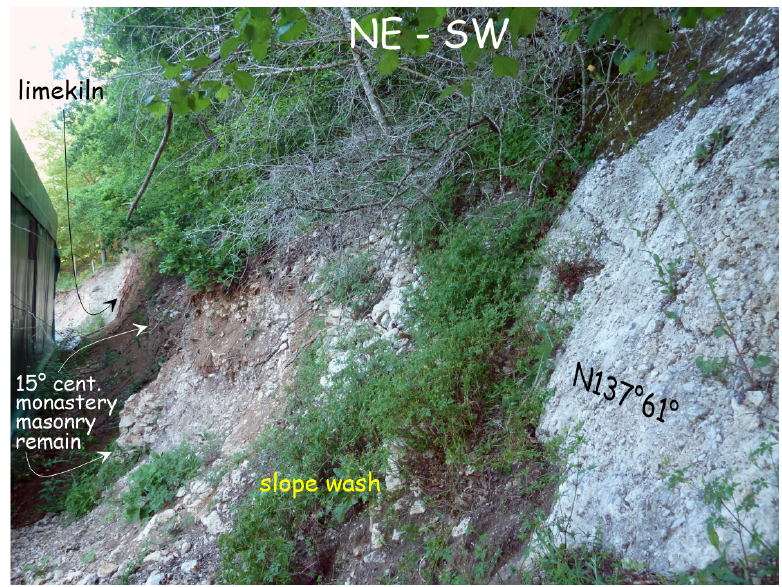
Figure 5. View looking northwest of the fault scarp and of the carbonate slickenside close to the kiln. The fault here juxtaposes marine limestone against cemented slope debris.